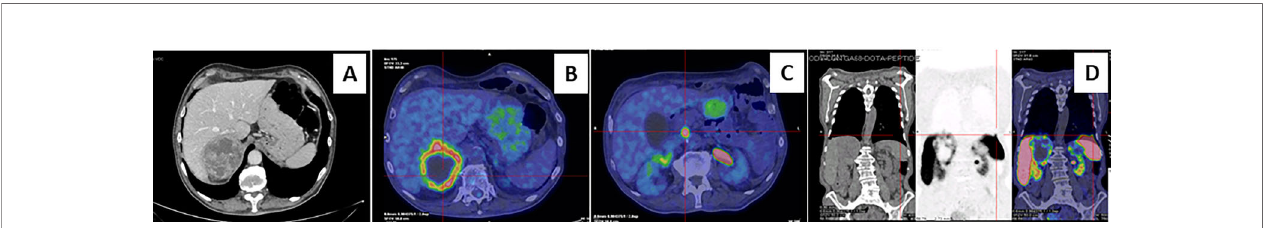
FIGURE 1 | Abdominal computed tomography scan and Positron emission tomography imaging. Contrast-enhanced abdominal CT scan showed inhomogeneous right adrenal mass measuring 8.1 x 7.7 x 7.9 cm (A) . A 18F- fl uorodeoxyglucose PET-CT showed an area of high uptake in the right adrenal gland, with a prevailing peripheral signal and central hypoactivity, and in the lumbar region suspected of adenopathic localization (B, C) . A 68GaDOTA-octreotate (DOTATATE) PET con fi rmed previous localizations and also detected a high uptake are at the base of the left lung